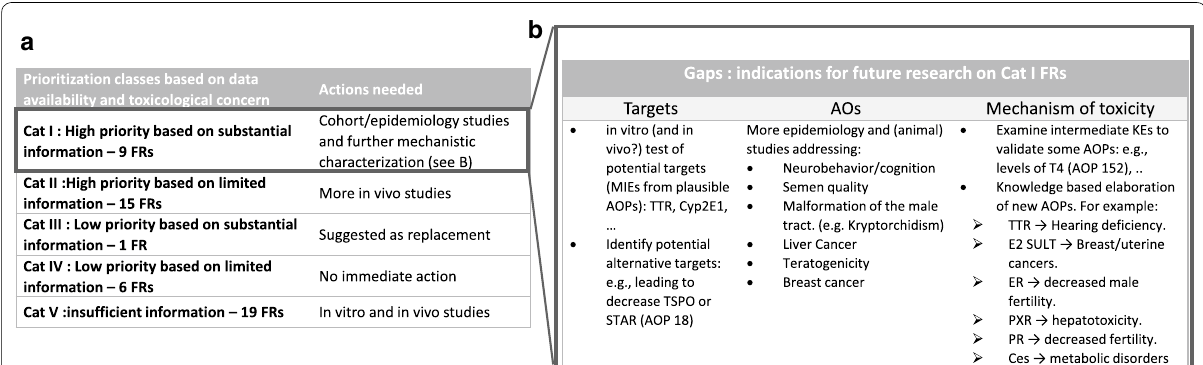
Fig. 3 Recommendation for future actions based on data availability, toxicological concern and future research on molecular targets, adverse health effects and mechanisms of toxicity of Category I